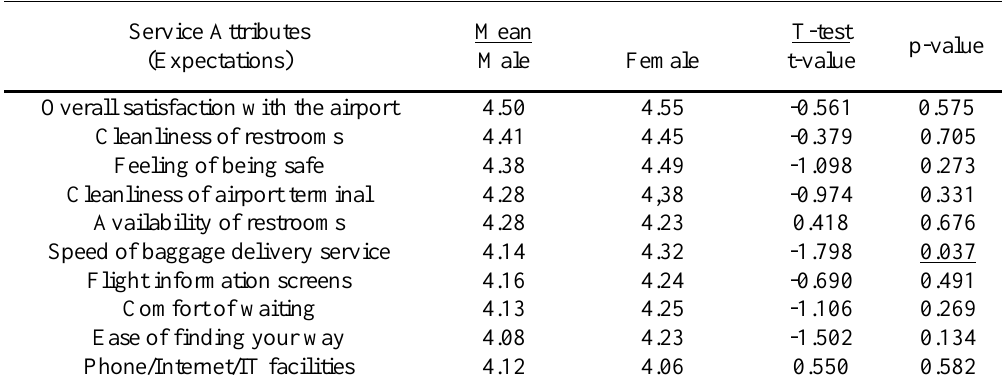
Table 3. Passengers’ expectations of level of